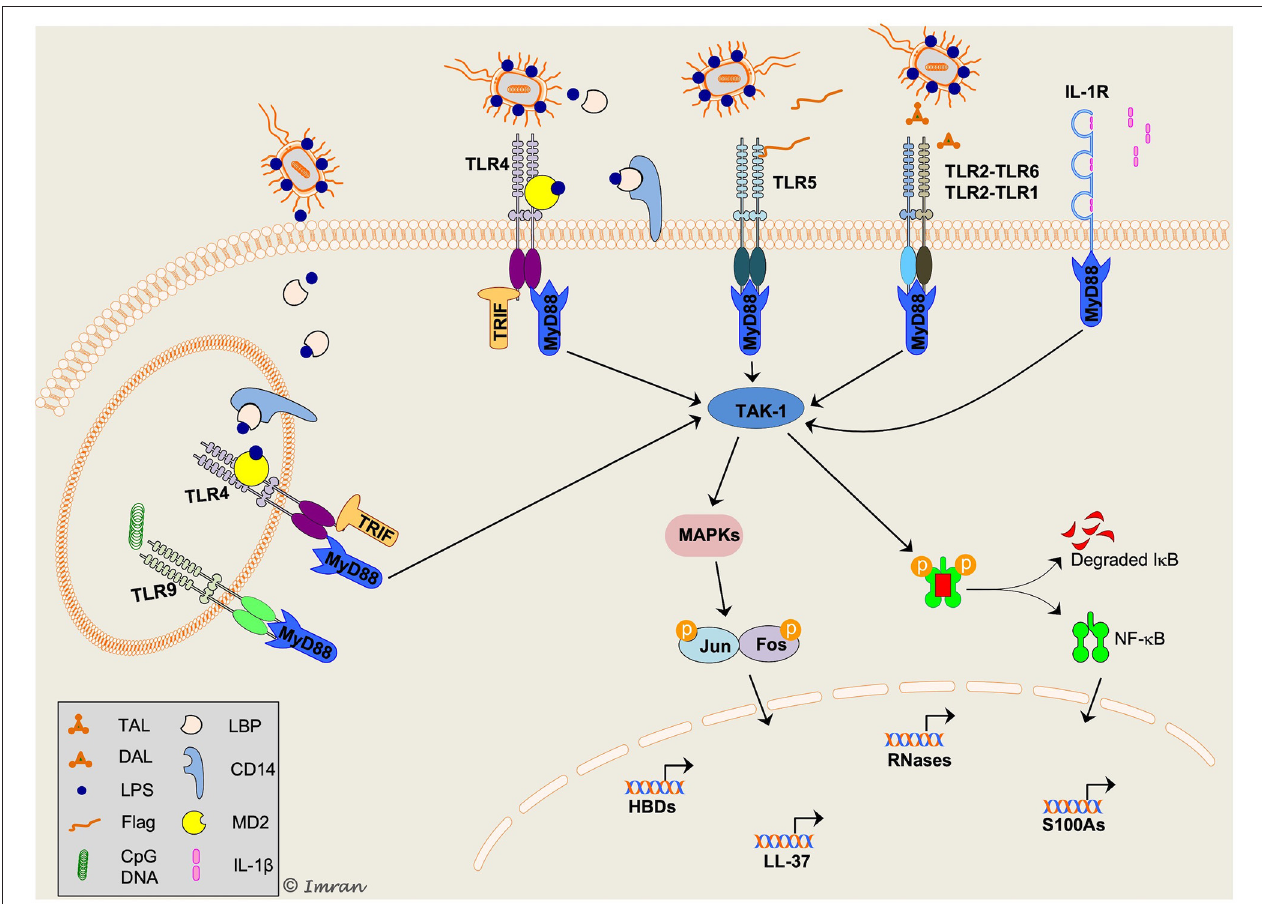
FIGURE 3 | Schematic representation of key signaling mechanisms involved in host defense peptides (HDPs) production in response to bacterial infection. Multiple intracellular signaling pathways are activated downstream of toll-like receptors (TLRs) in response to a variety of pathogen-associated molecular pattern (PAMPs), resulting in production of HDPs and cytokines/chemokines. TLR2/1 and TLR2/6 are shown to recognize diacylated (DAL) and triacylated (TAL) lipopeptides, respectively. TLR4 is present both on cell-surface and intracellularly on endosomes specifically recognizes lipopolysaccharide (LPS). LPS is recognized by LPS binding protein (LBP) and presented to CD14 (present in a soluble form in tear fluid), which transports LPS to myeloid differentiation-2 (MD-2)/TLR4 complex. Flagellin (Flag), a flagellar protein of Gram-negative bacteria, is recognized by TLR5. TLR9 present on endosomes recognizes CpG containing bacterial DNA; however, its role in production of HDPs and associated signaling mechanisms in corneal epithelial cells remain unclear. A pleiotropic cytokine, interleukin-1 β (IL-1 β ) is recognized by IL-1R on cell surface. Activation of toll/IL-1-receptor (TIR) domain of both TLR and IL-1R triggers recruitment of the adaptor molecule myeloid differentiation primary response protein 88 (MyD88). TLR4 signaling can be activated via MyD88 and TIR-domain-containing adaptor protein inducing interferon- β (TRIF). Both MyD88 and TRIF initiate phosphorylation and ubiquitylation of several other molecules (not shown) leading to activation of transforming growth-factor- β activated kinase-1 (TAK1). In the cytosol, TAK-1 triggers activation of mitogen-activated protein kinases (MAPKs) and nuclear-factor- κ -B (NF- κ B) pathways. This allows nuclear translocation of NF- κ B and activator protein 1 (AP-1; complex of Jun and Fos protein) transcription factors and modulates expression of target HDPs. The scheme was adapted from Mohammed et al. paper